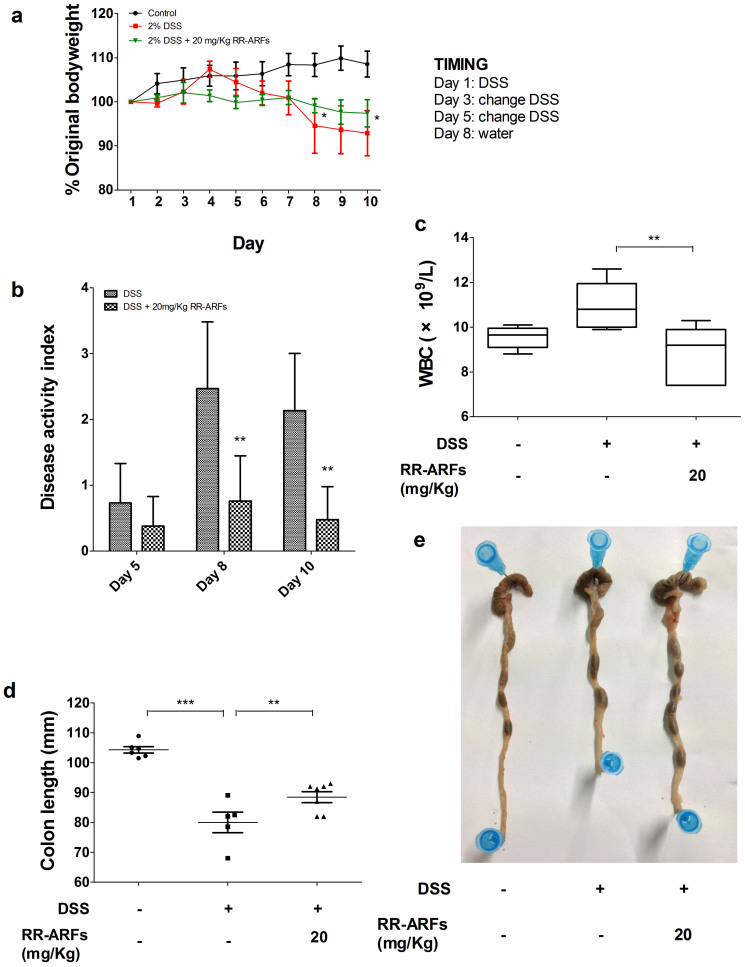
RR-ARFs alleviate DSS-induced pathology.BALB/c mice were injected with RR-ARFs (20 mg/kg) 1 day prior to exposure to 2% DSS in drinking water. Daily weights were measured (n = 6–8/group) and plotted as percentage body weight change from initial weight, expressed as group percentage mean ± SEM (a). Disease activity index (b). Hematological parameters was tested using MINDRAY BC-3000 PLUS Automatic Hematology Analyzer (c). Analysis of colon length from experimental mouse groups (d and e). Representative of two independent experiments. * P < 0.05, ** P < 0.01 compared to DSS-only control.